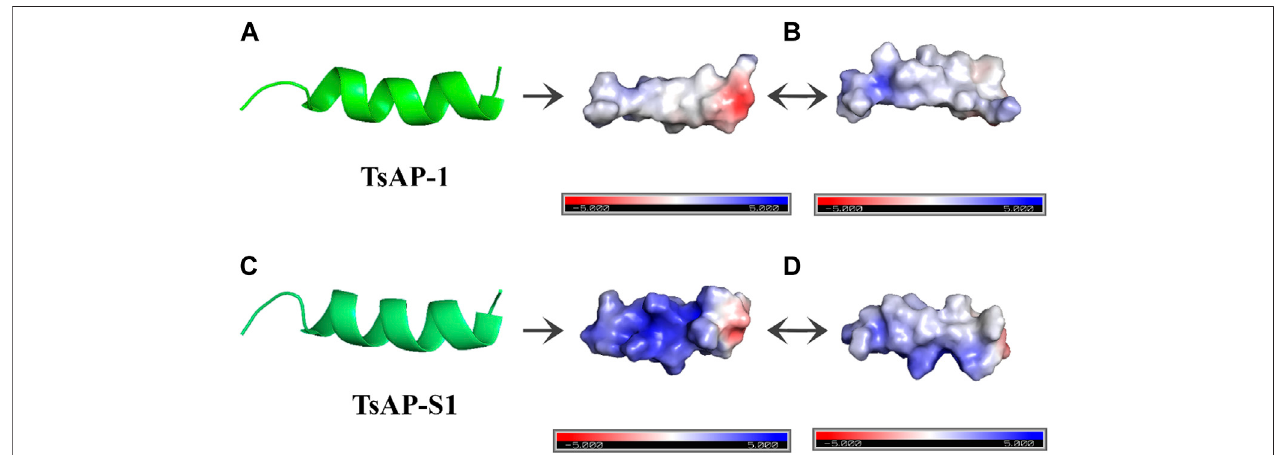
FIGURE 3 | Antimicrobial peptides visualized using PyMol. (A,C) Peptide tridimensional view of TsAP-1 and TsAP-S1, respectively. (B,D) Different angles of the electrostatic surface created through Adaptive Poisson – Boltzmann solver (APBS). The negatively charged surface is shown in red, the positively charged surface is shown in blue, and the neutrally charged surface is shown in